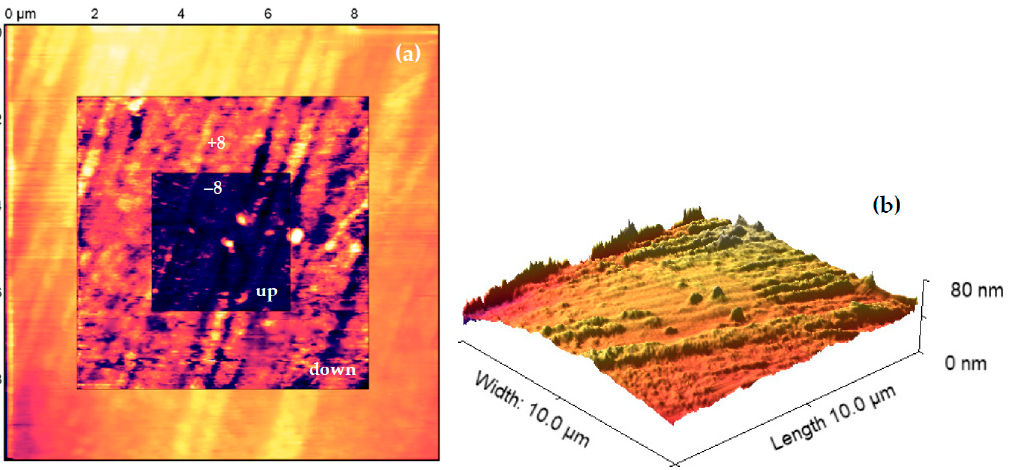
Figure 8. Topography of 100 nm thick BFO Pt/TiO 2 /Si ( a ) square pattern +/ − 8 and 0 V bias ( b ) 3D topography.